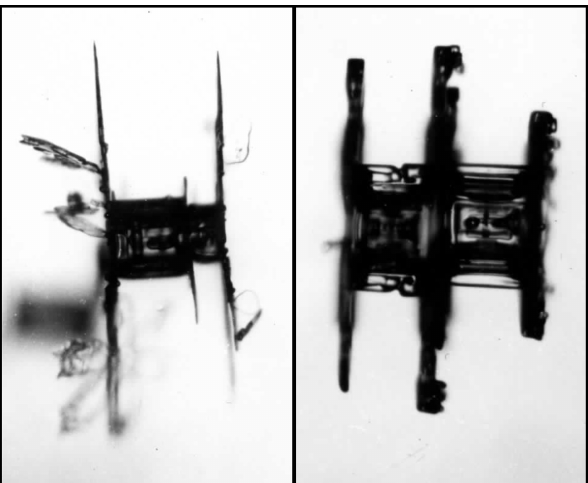
Figure B5. Multiple-capped columns from the Magono–Lee collec- tion (Magono and Lee, 1966).